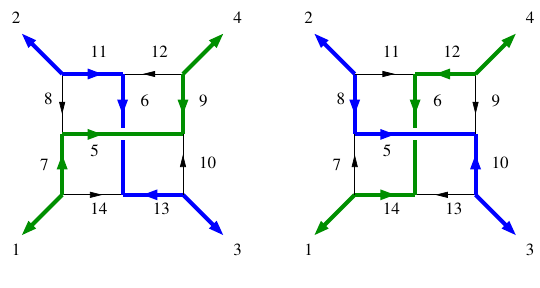
Figure 6 . Possible momentum routings for I ( h )